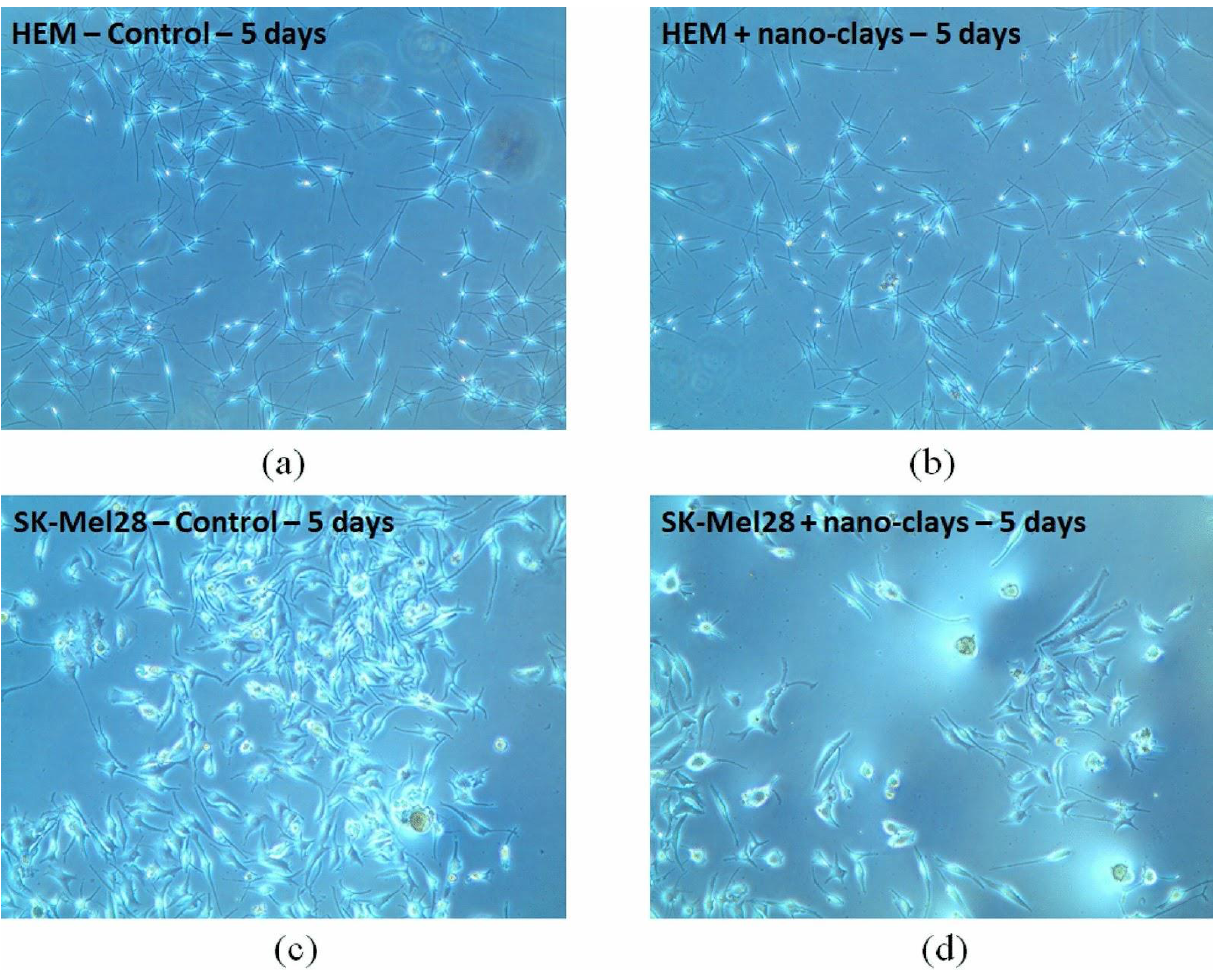
Figure 6. Cell viability of control (untreated) melanocytes (HEM) ( a ) and melanoma (SK-Mel-28) ( c ) after 5 days of incubation; viability of HEM ( b ) and SK-Mel-28 ( d ) cells 5 days after treatment with the nano-clay mixture. Reproduced from ref. [103].